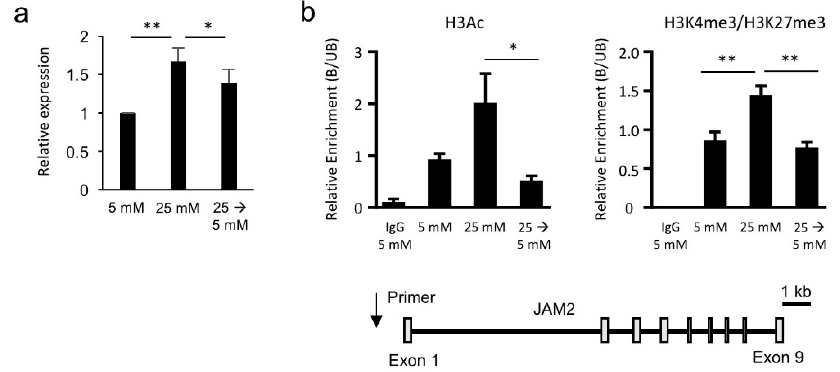
Figure 3. Junctional adhesion molecule 2 (JAM2) is a hyperglycemia-regulated gene in hPVCs. ( a ) qPCR analysis for JAM2 expression levels in hPVCs cultured in NG (5 mM) and HG (25 mM) for 15 days. hPVC were exposed in HG (25 mM) medium for 5 days followed by NG (5 mM) medium for 10 days. Switch HG to NG medium significantly decreased JAM2 expression. Bars indicate the mean ± SD. * p < 0.05, ** p < 0.01. ( b ) qChIP analysis of acetylated lysine 3 of histone 3 (H3Ac) or ratio of tri-methylation